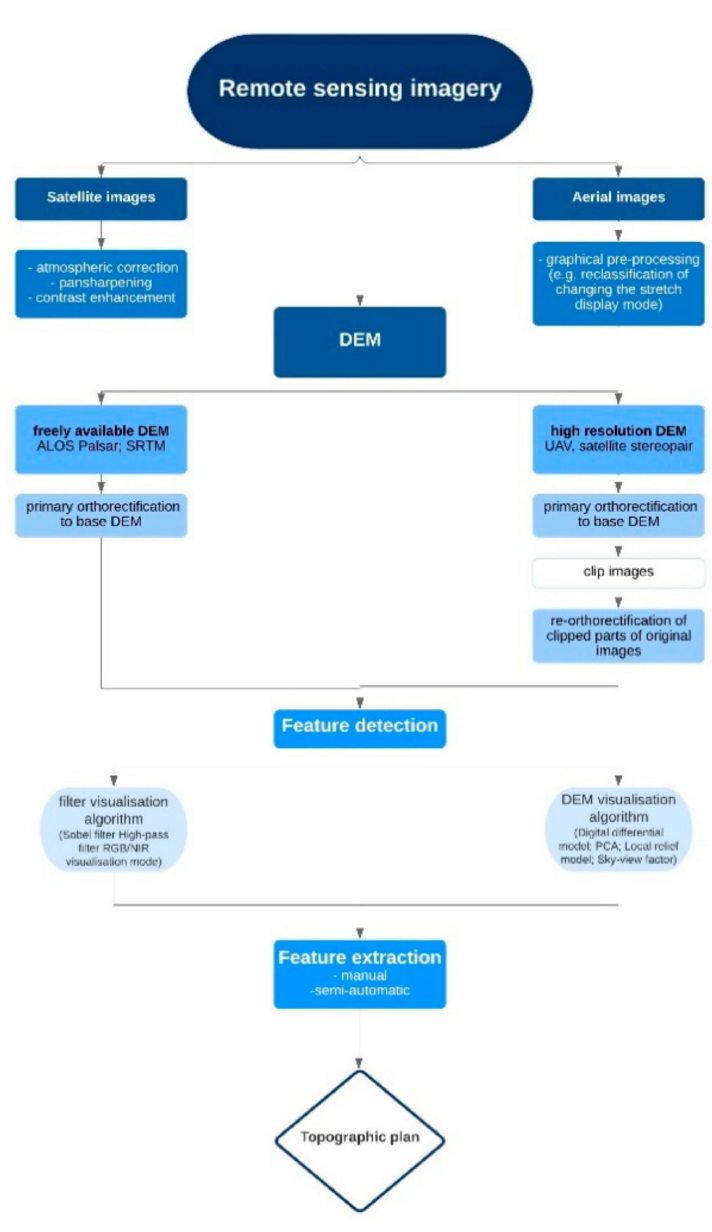
Figure 3. Overview of the general methodological workflow (author: Lenka Starkov á